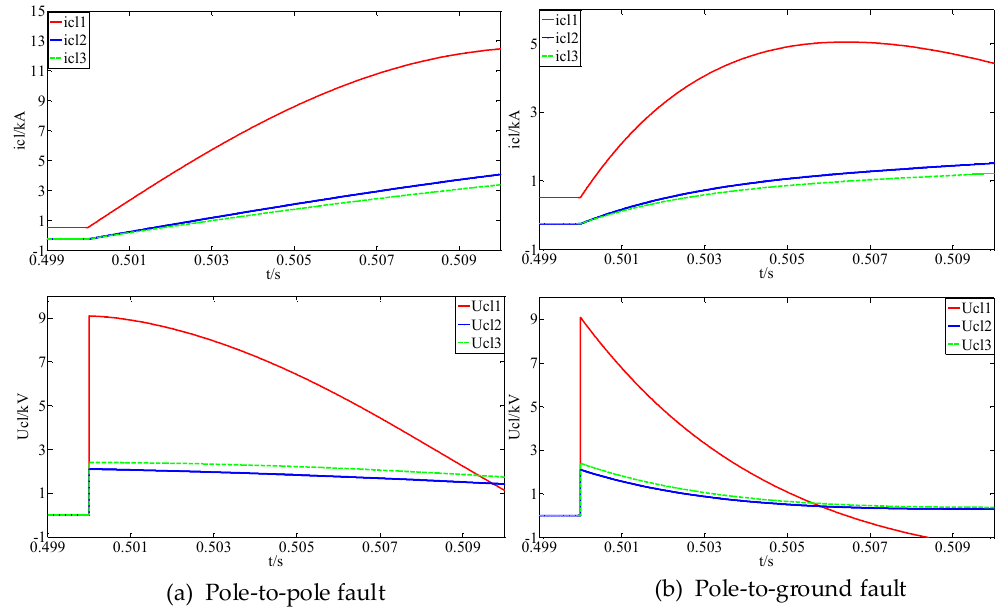
Figure 2. Simulation results of the currents and voltages of the CLIs during DC faults in the multi-terminal radial AC/DC hybrid distribution network.